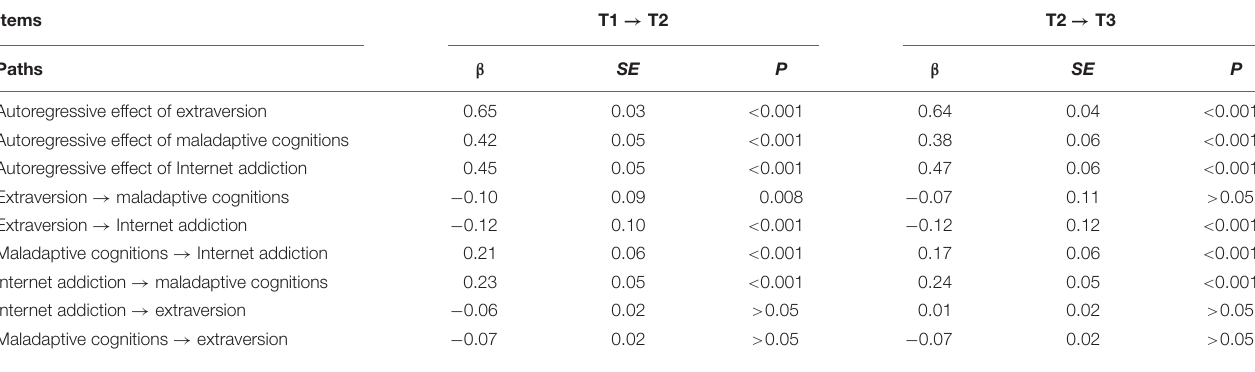
TABLE 4 | Regression coefficients of cross-lagged associations among extraversion, maladaptive cognitions, and Internet addiction within